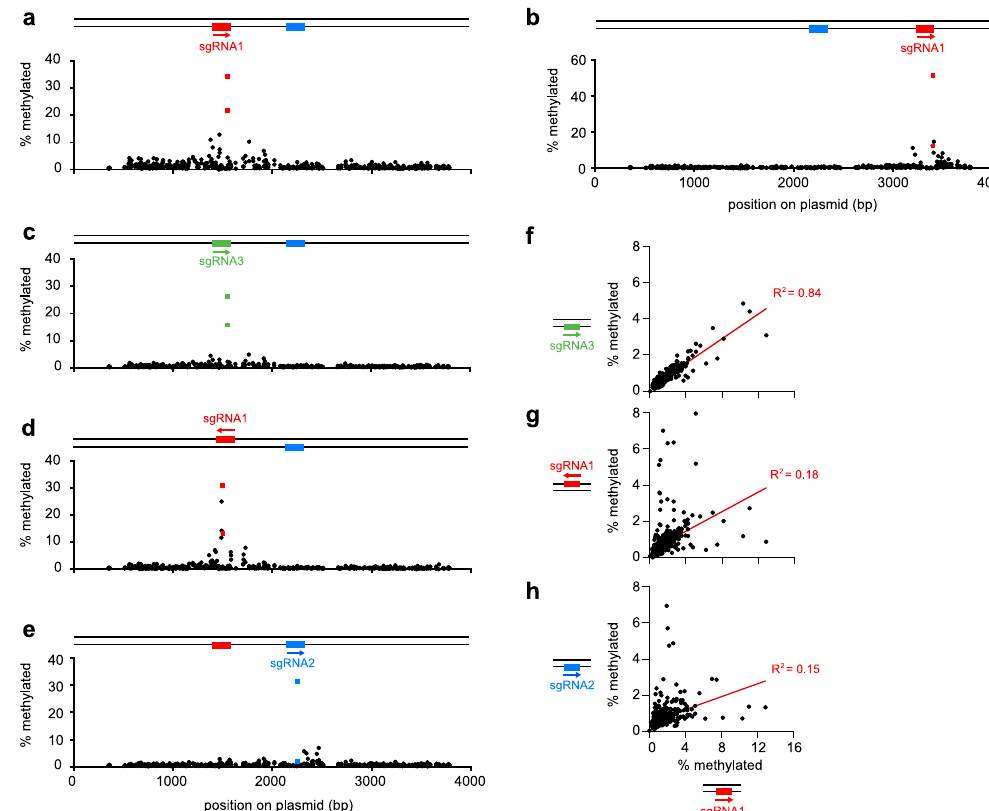
Figure 3. The location and level of off-target DNA methylation depends upon the location of the targeted sgRNA protospacer in the plasmid and its relative orientation. ( a–e ) Methylation of CpG sites as a function of position on the plasmid and sgRNA (arrows) as determined by high throughput bisulfite sequencing. The frequency of methylation at the target sites CpG (colored squares) and the 482 off-target sites (black circles) is shown. The presence and location of an sgRNA’s binding site on the plasmid is indicated by a colored rectangle on the schematic of dsDNA above the graph the x-axis. Enlarged log-scale graphs of the fraction methylated plotted with error bars (along with additional negative controls) are provided in Supplementary Fig. S2. ( f ) Correlation of off-target methylation frequencies when site 1 is replaced with site 3 on the plasmid. ( g ) Non- correlation of the off-target methylation levels when comparing inverted protospacer sites for the same sgRNA. ( h ) Non-correlation of off-target methylation frequencies when the dCas9-MC/MN is directed to different sites by different